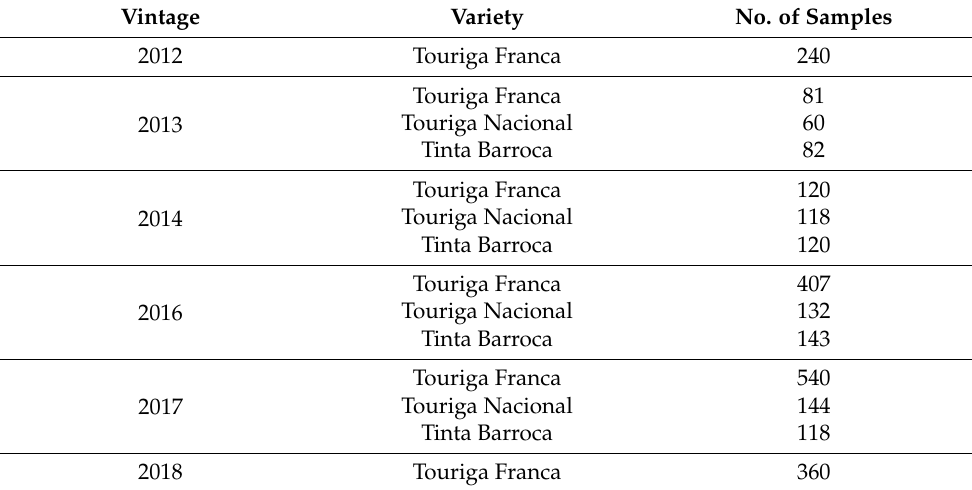
Table 1. Number of samples collected for each vintage and